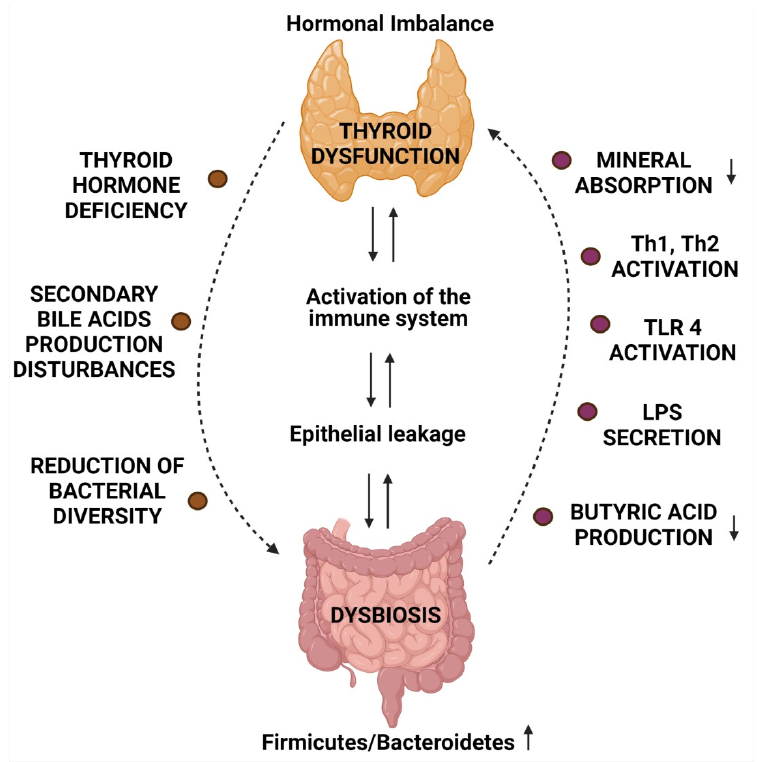
Figure 2. The relationship between dysbiosis and thyroid dysfunction (created with BioRender.com).